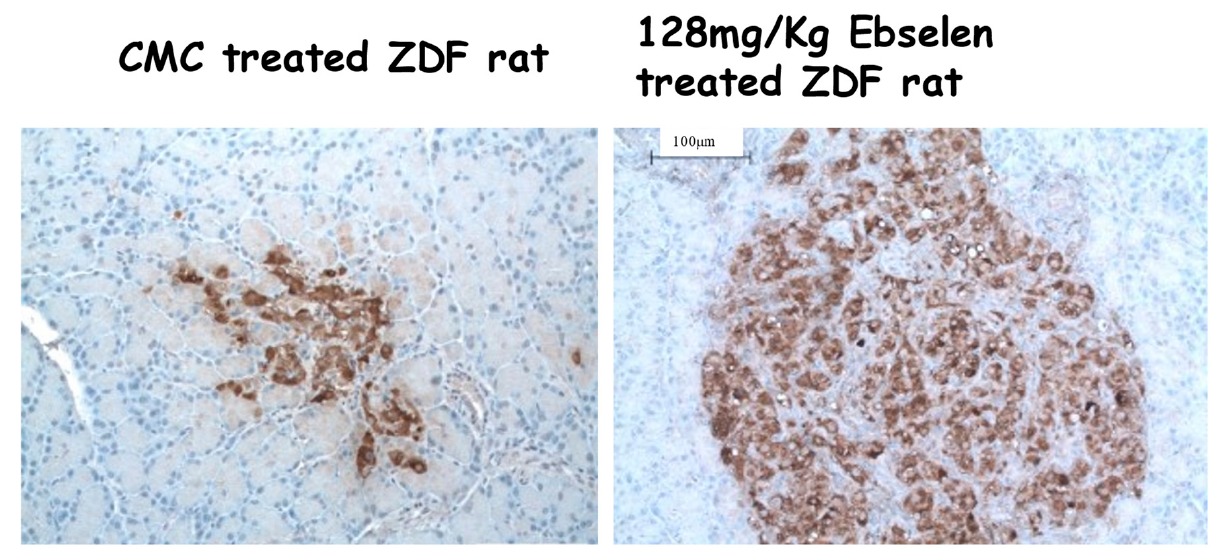
Figure 4. Comparison of islet morphology in a control (CMC) and an Ebselen-treated ZDF rat. Taken as a whole, the average total beta cell mass in the ebselen group doubled. Bar in left corner of right image indicates relative sizes of both images. Modified from Ref. [22].